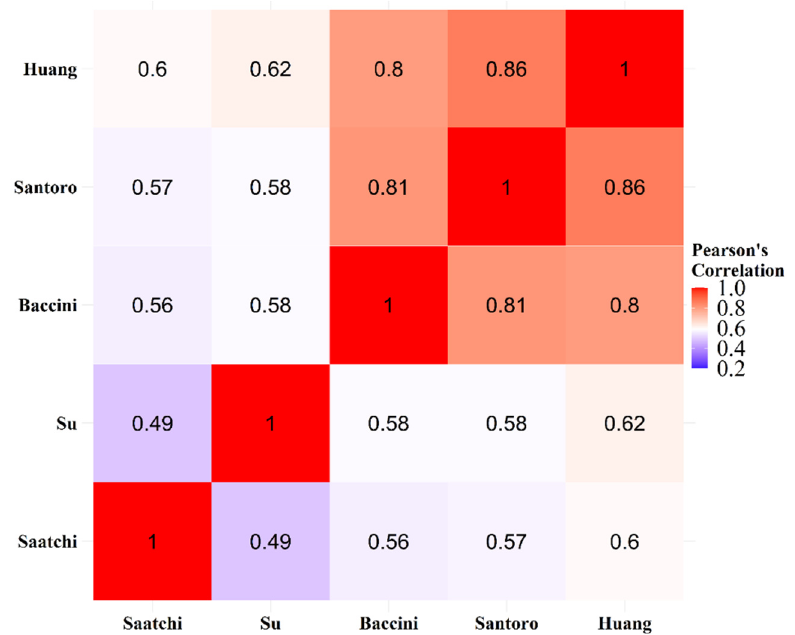
Figure 2. Error correlation between the participating AGB products used as a measure of the dependence of their errors.